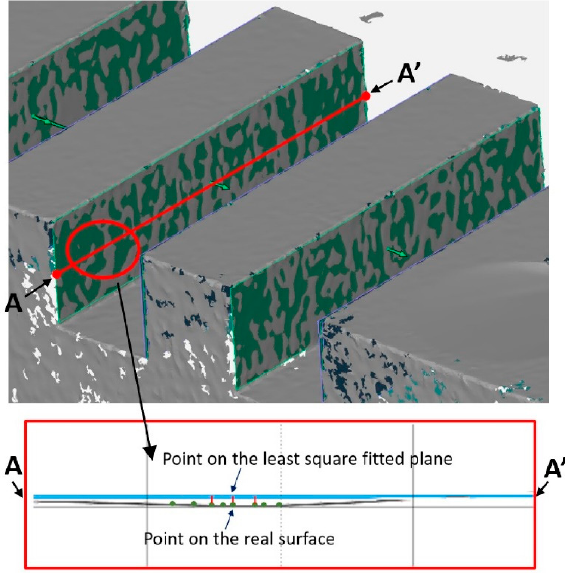
Figure 5. Fitting error description.